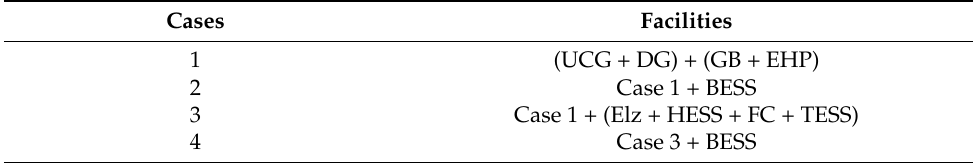
Table 1. Composition of IES.